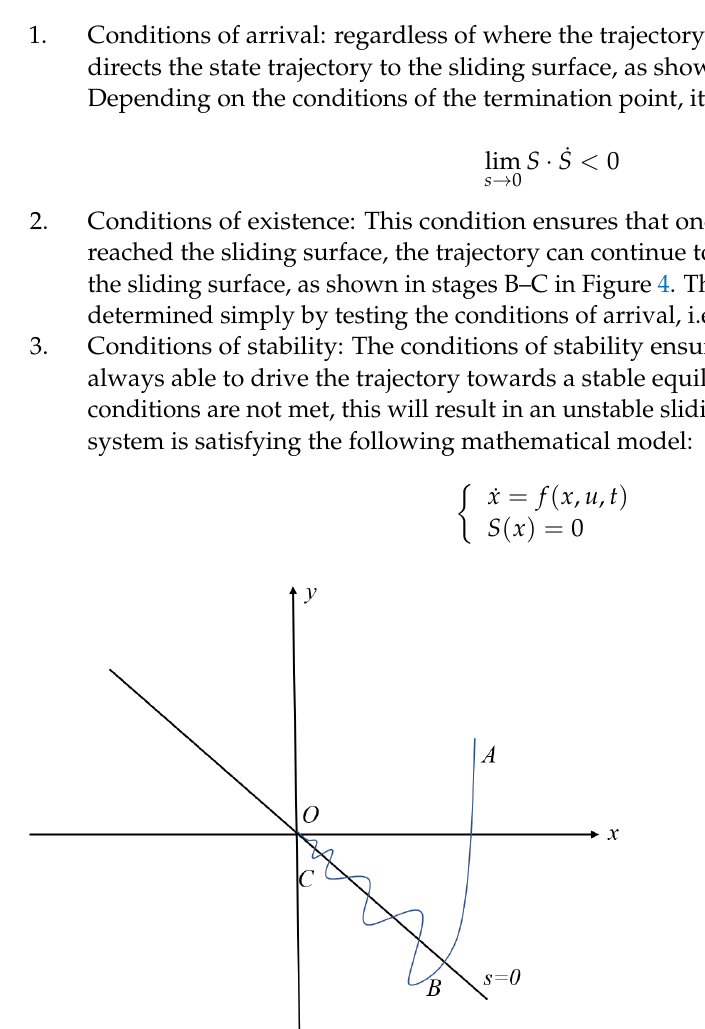
Figure 4. CLLC resonant converter equivalent circuit